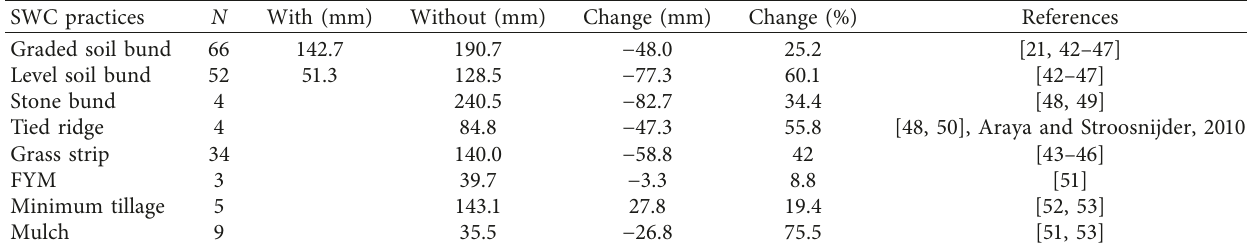
Table 10: The impact of SWC practices on surface runoff in